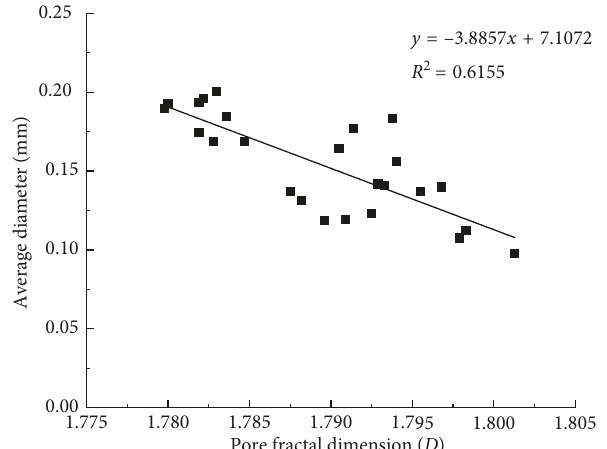
Figure 12: Relationship between pore fractal dimension and the average